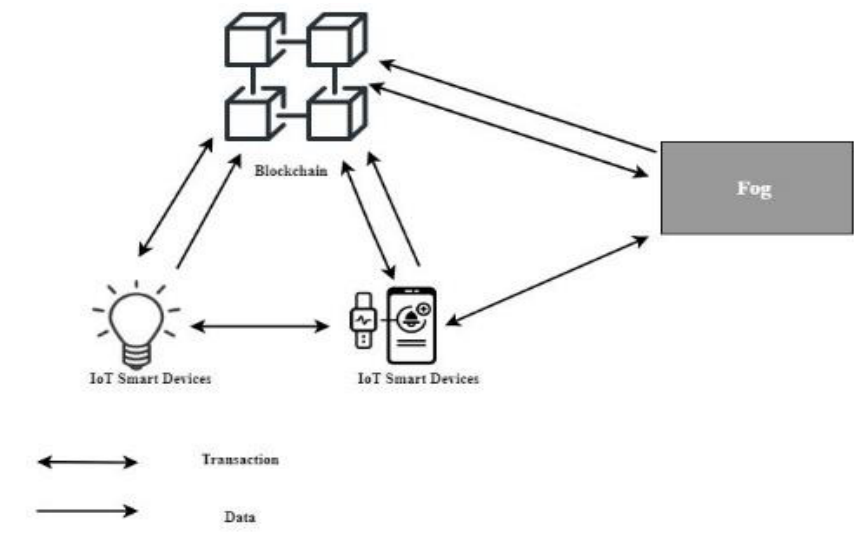
Figure 17. BIoT based fog